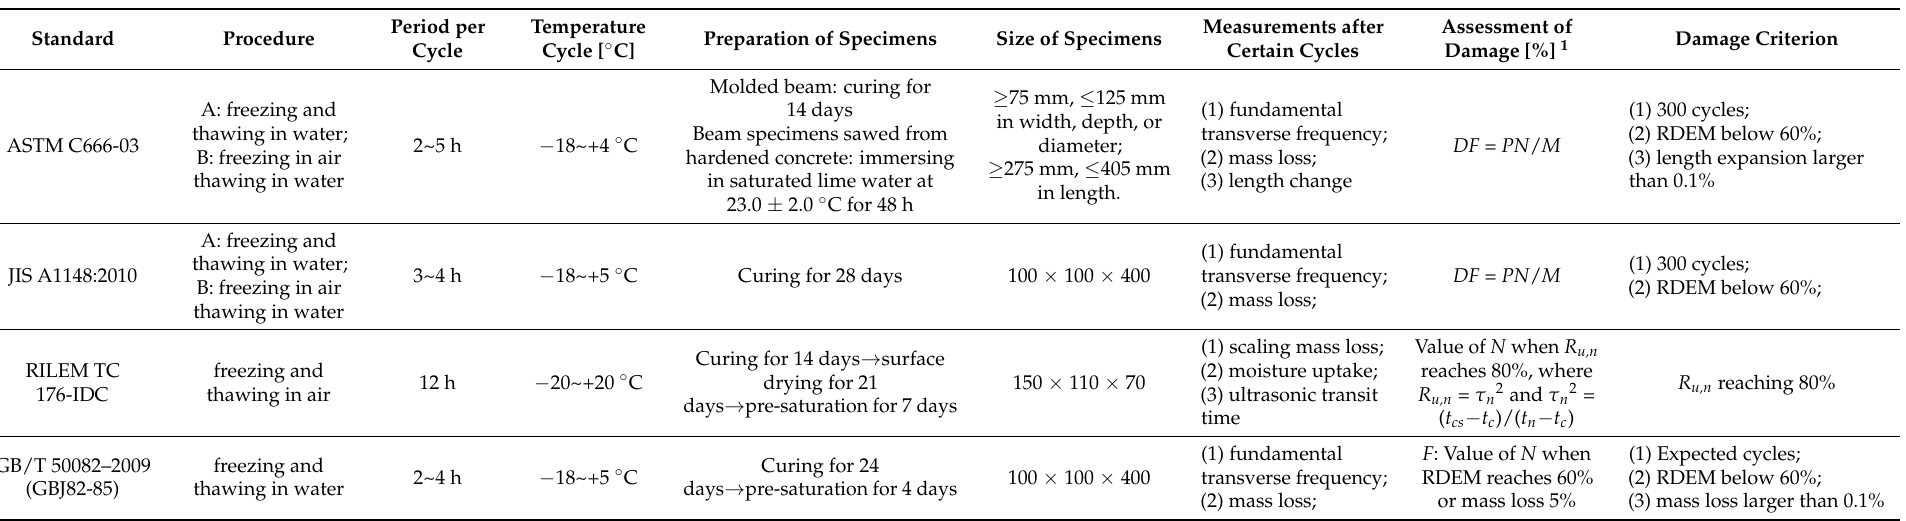
Table 1. Freezing-thawing conditions and tested values in various standards.